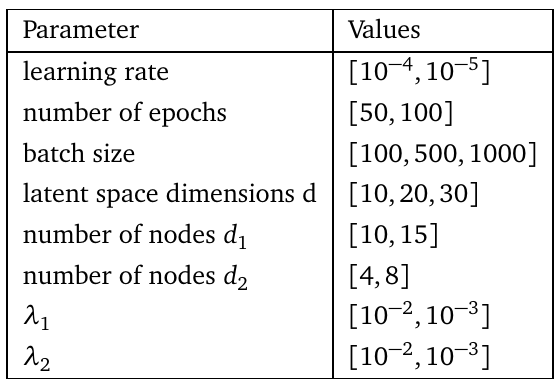
Table 19: DAGMM model